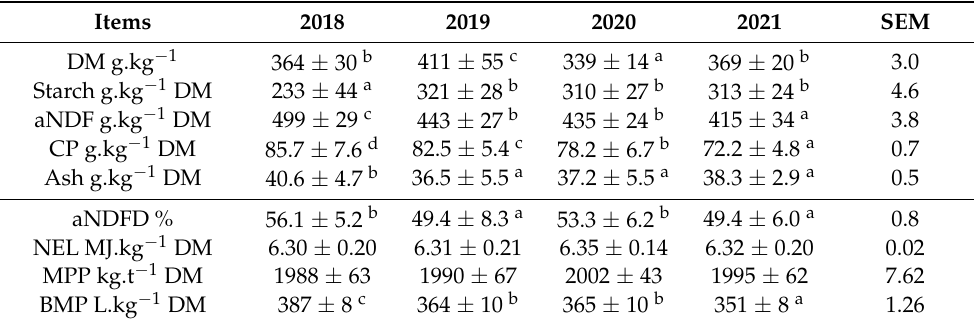
Table 5. Chemical composition and feed value of hybrids in different years.